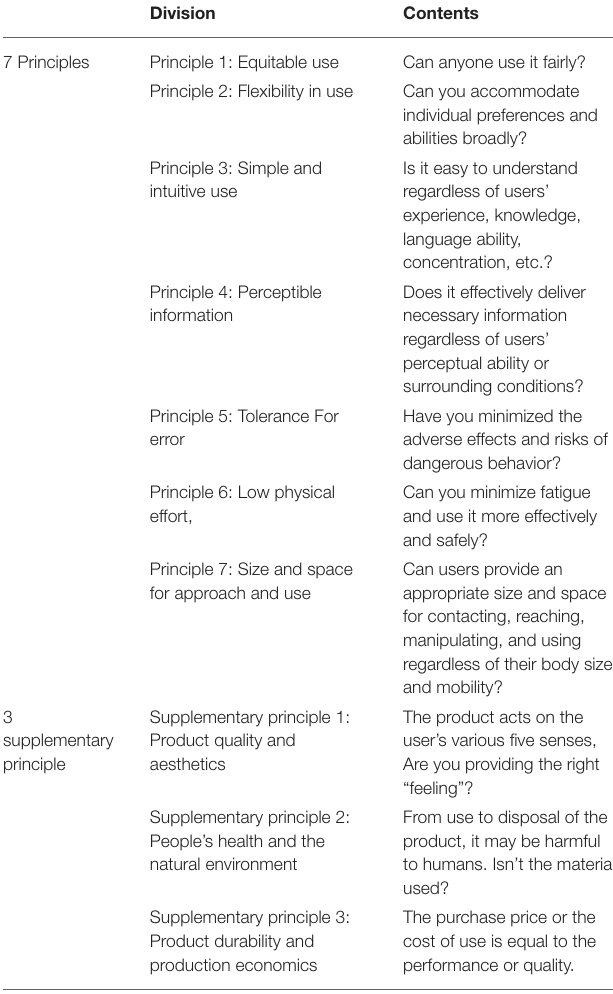
TABLE 2 | Seven principles of UD and three supplementary principle of PPP. Division